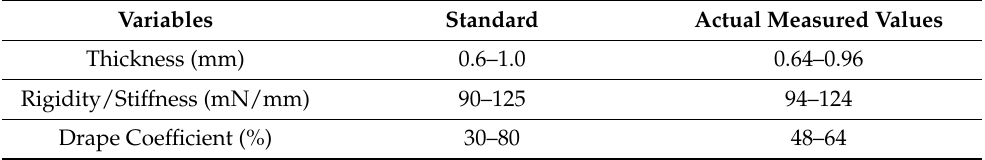
Table 1. Variables and their